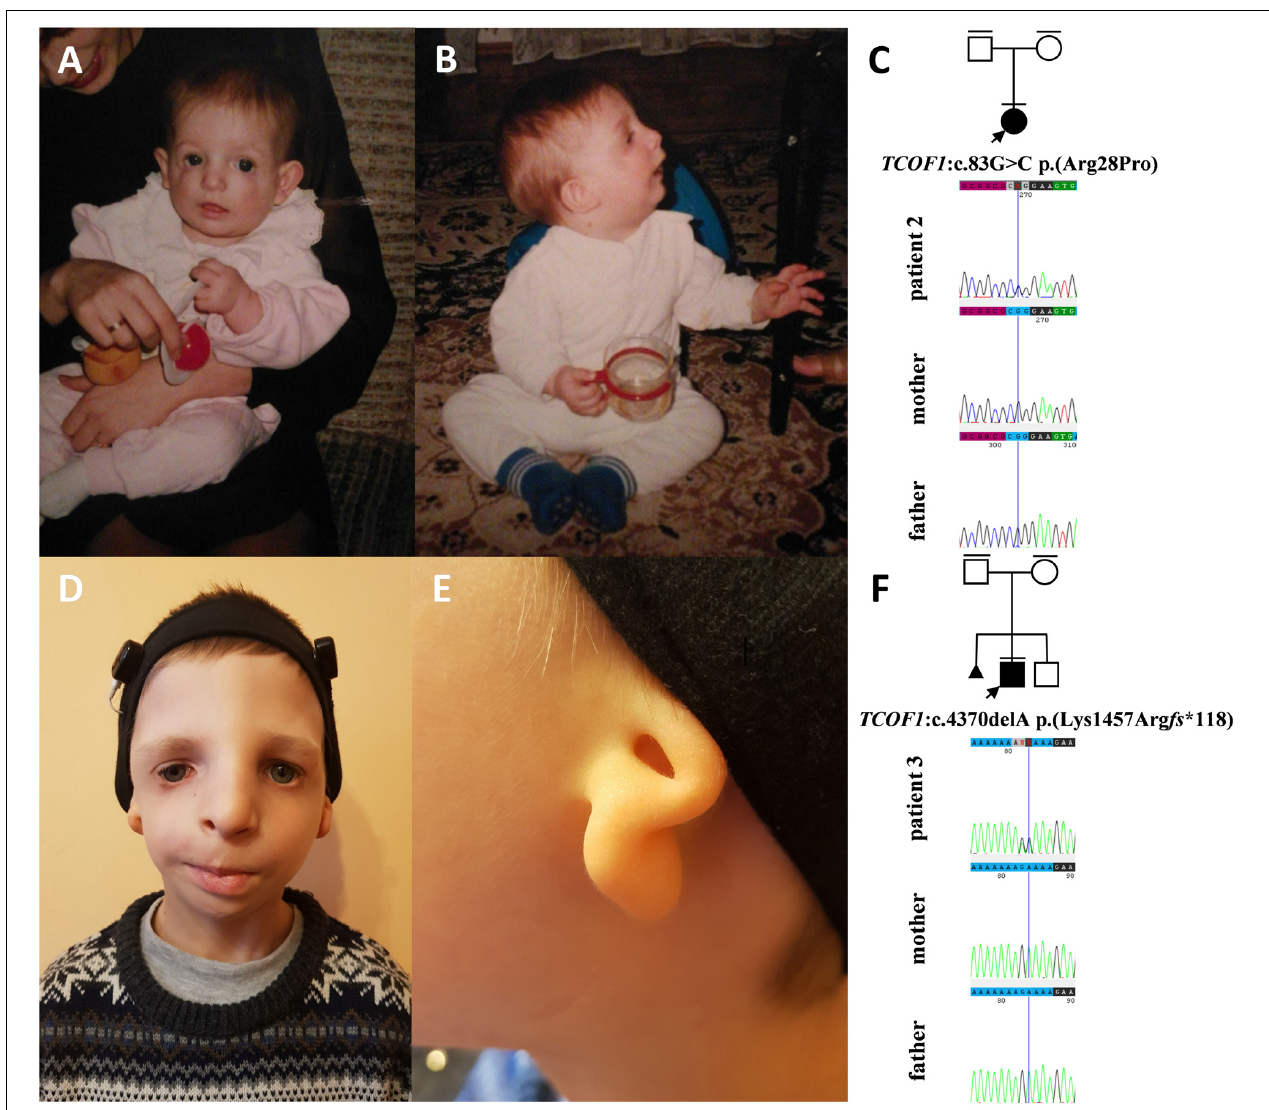
FIGURE 3 | Clinical characteristics and segregation results of patient 2 (A–C) and 3 (D–F) affected by Treacher Collins syndrome. Patient 2 carries a heterozygous variant c.83G > C p.(Arg28Pro) within the TCOF1 gene, which occurred de novo (C) whereas patient 3 carries a heterozygous variant